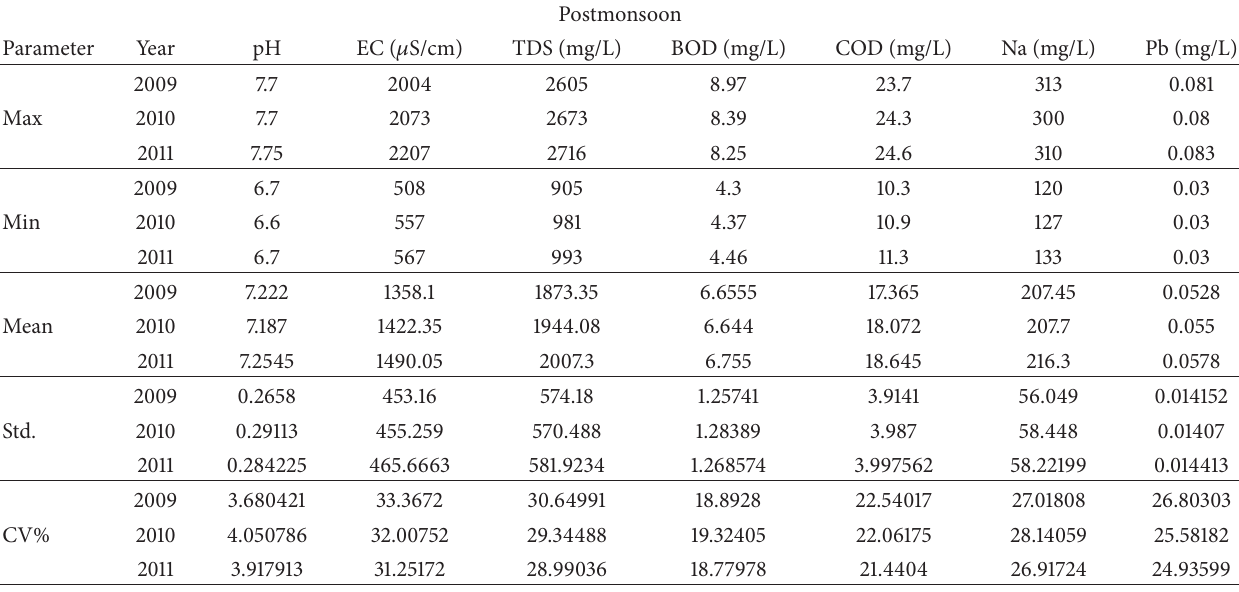
Table 6: Statistics of three years (2009–2011) groundwater quality data—postmonsoon.